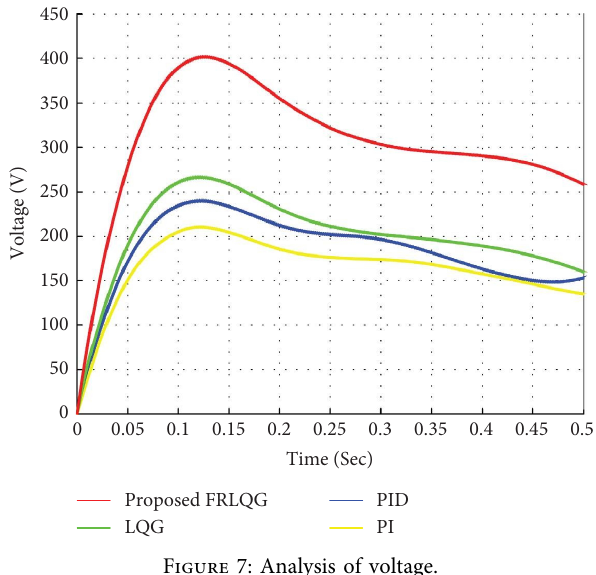
Figure 7: Analysis of voltage.